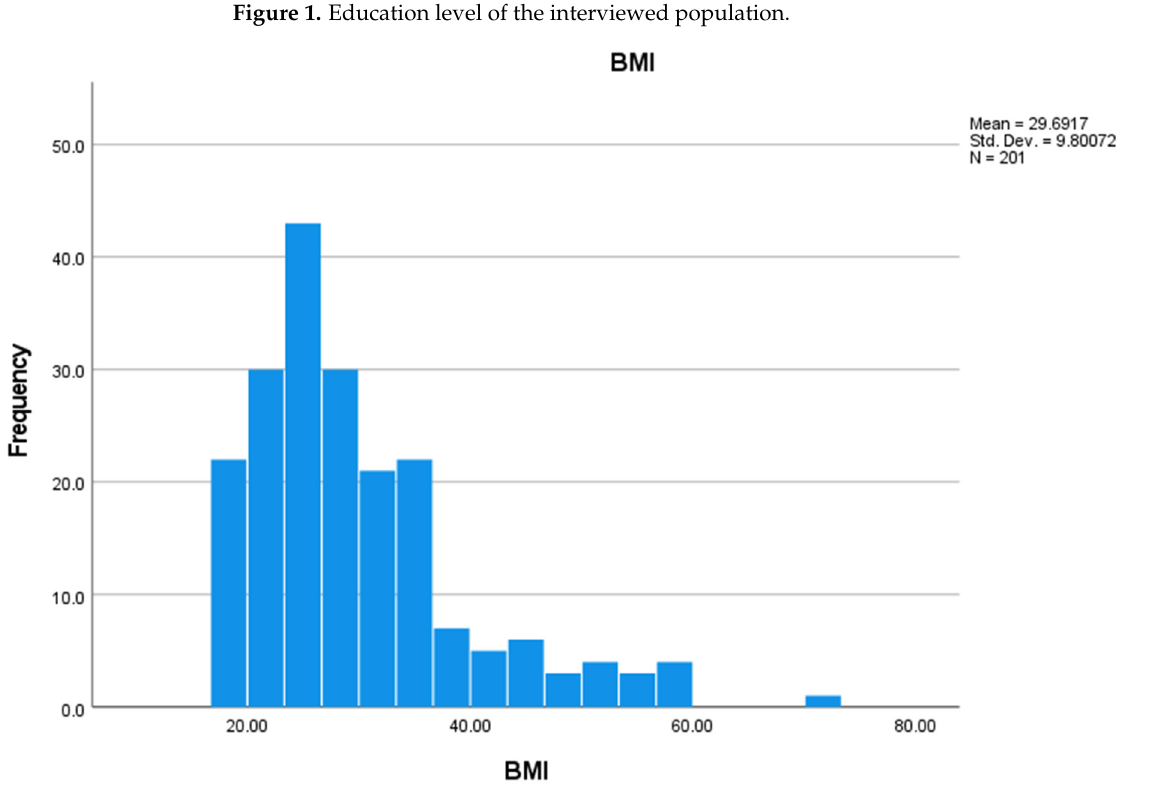
Figure 2. BMI of the analyzed sample. Table 3. Did you get infected with COVID-19?